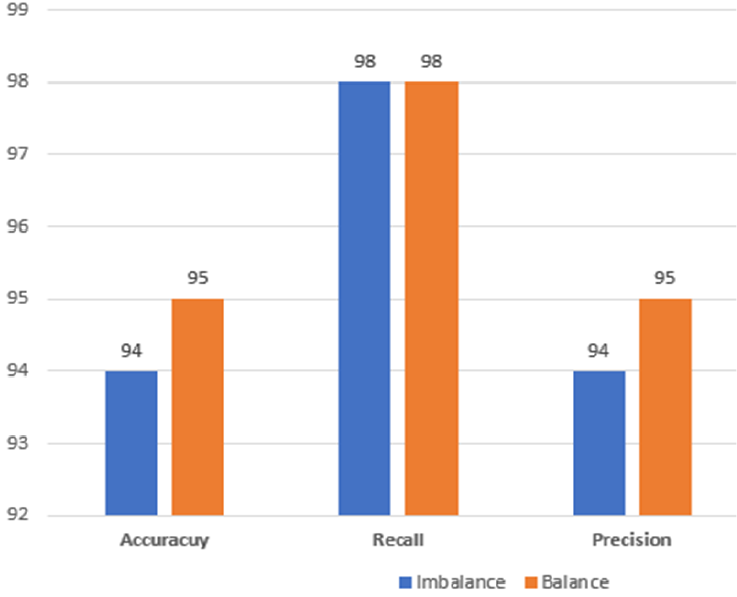
Figure 4. Performance Evaluation for Balanced and Imbalanced Data.